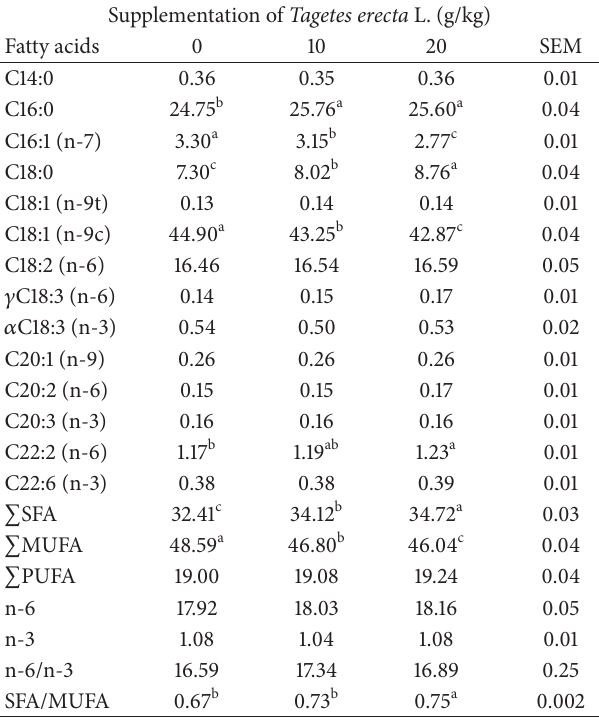
Table 2: The effects of Tagetes erecta L. supplementation on body weight, feed consumption, egg production, and egg weight.